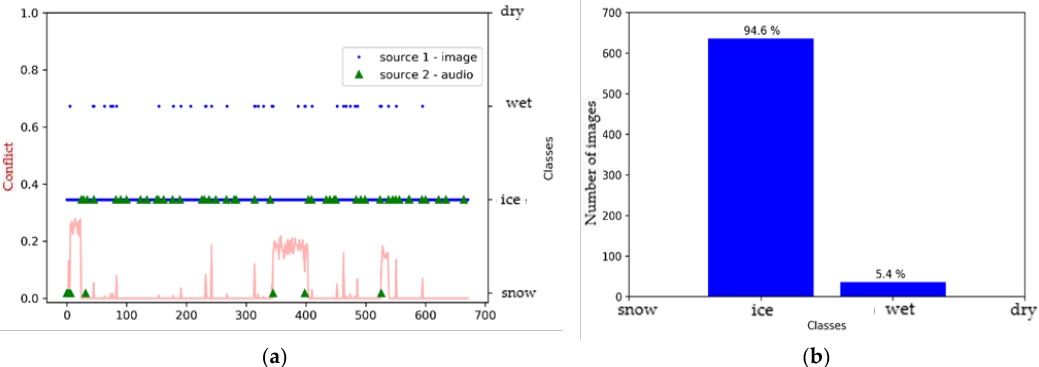
Figure 8. Environment #1 ( a ) Classification of sources with ResnetNet50 (video) and M5 (audio) prior to fusion, together with conflict analysis; ( b ) histogram prior to image fusion.